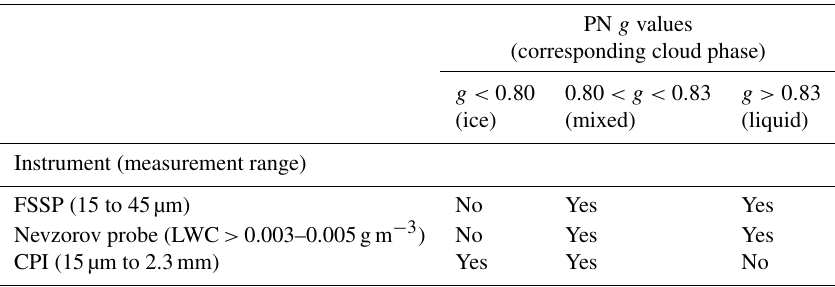
Figure 2. (a) Normalized scattering phase function according to the normalized altitude from polar nephelometer measurements (few µm to around 800µm size range), averaged over all the campaigns. g values indicate the cloud phase: g < 0.80: ice; 0.80 < g < 0.83: mixed; and g > 0.83: liquid. (b) Mean vertical profile of asymmetry parameter (for all the campaigns). The grey bars indicate the threshold g values for the assessment of ice, mixed and liquid cloud phases. Table 4. Summary of the method for the assessment of the cloud thermodynamical phase and liquid droplet and ice crystal properties from the combination of PN, CPI, FSSP and Nevzorov